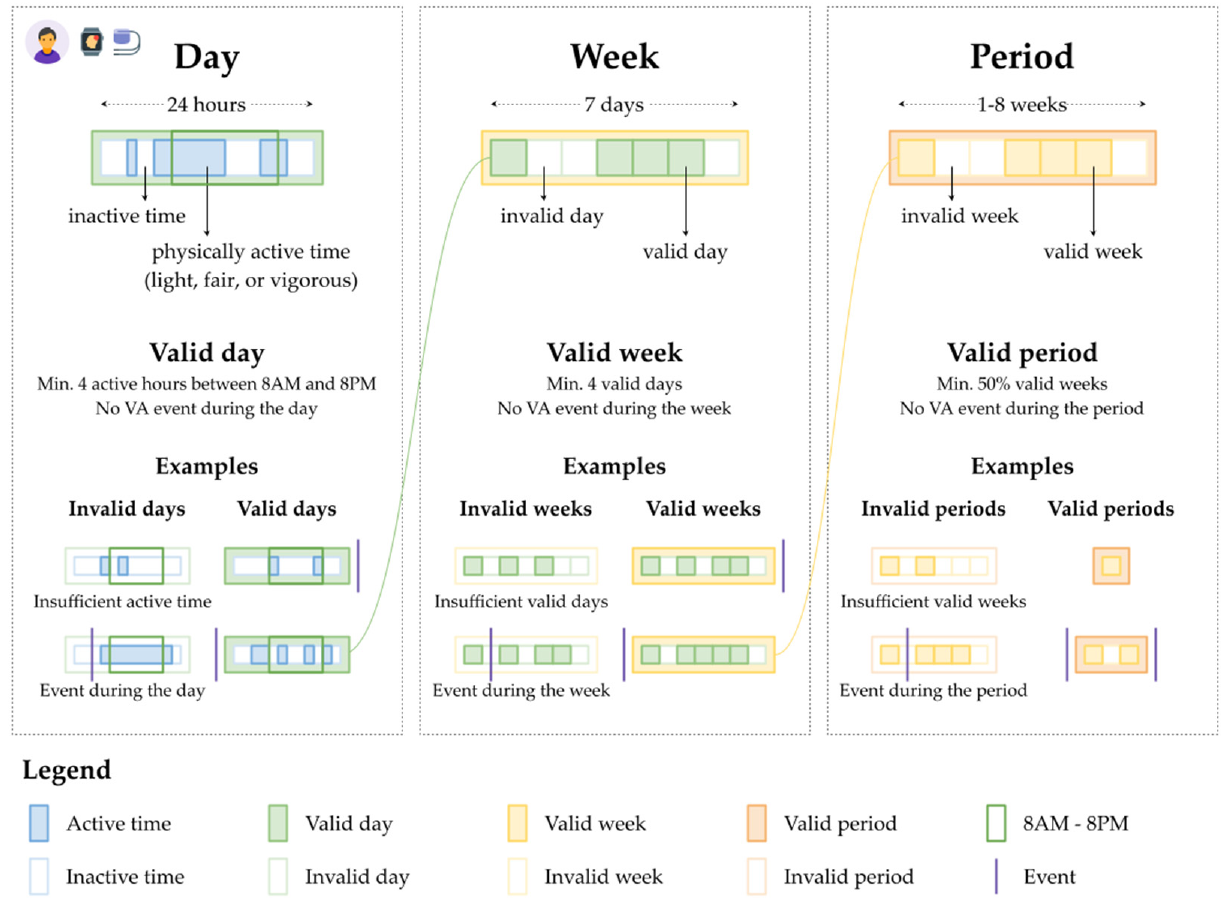
Figure 1. Data validation for days, weeks, and periods for one combination of scenarios: at least four hours of physical activity data between 8 a.m. and 8 p.m. for valid days, at least four valid days for valid weeks, and at least 50% valid weeks for valid periods. Days (depicted in green in the top left ) contain physically active or inactive time (physically active time is depicted with solid blue, while physically inactive time is depicted with pale blue). If at least 50% of the time between 8 a.m. and 8 p.m. is active, the day is valid. Weeks (depicted in yellow in the top center ) contain seven days (valid days are depicted with solid green, while invalid days are depicted with pale green). If the week has at least four valid days, that week is valid. Periods (in orange in the top right ) contain 1–8 weeks (valid weeks are depicted with solid yellow, while invalid weeks are depicted with pale yellow). If at least 50% of the weeks of a period are valid, the period is valid. The figure then shows examples of valid and invalid days (bottom left), weeks (bottom center), and periods (bottom right).